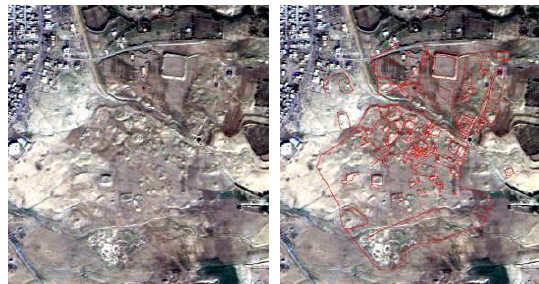
Figure 13 - Makhmúr al-Qadíma - a RGB synthesis of the FORMOSAT-2 images (acquired on 2 11. 2014) with an overlaid objects of interest on the left picture.